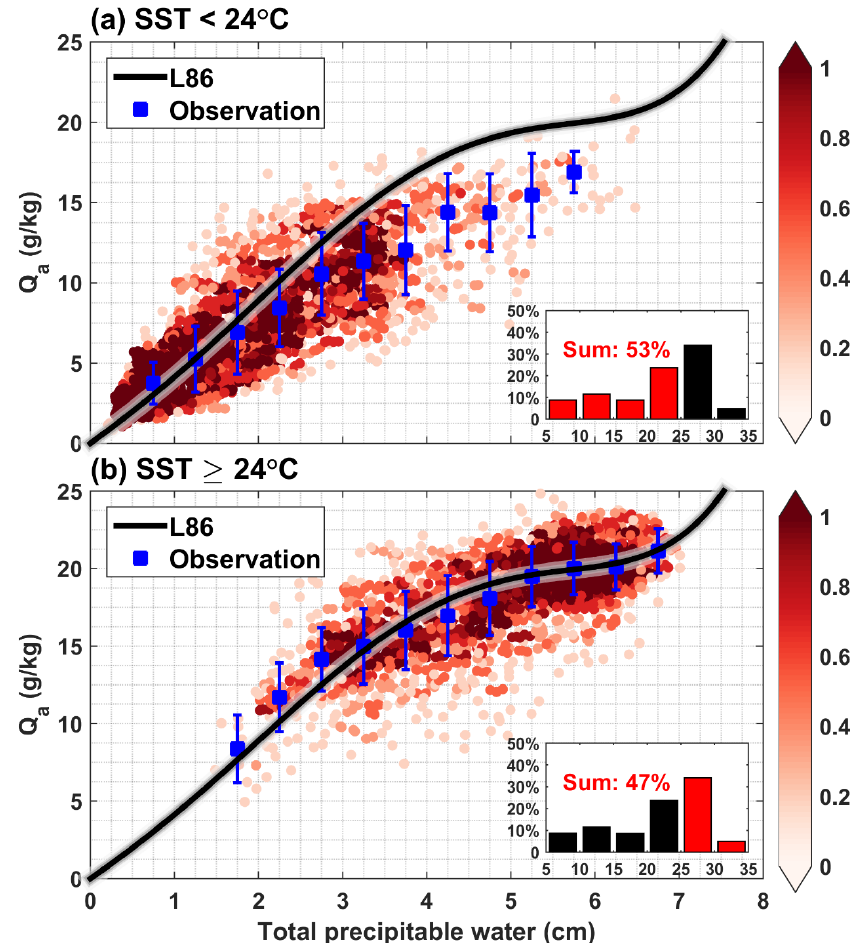
Figure 9. The same as Figure 7 but for two conditions of SST.